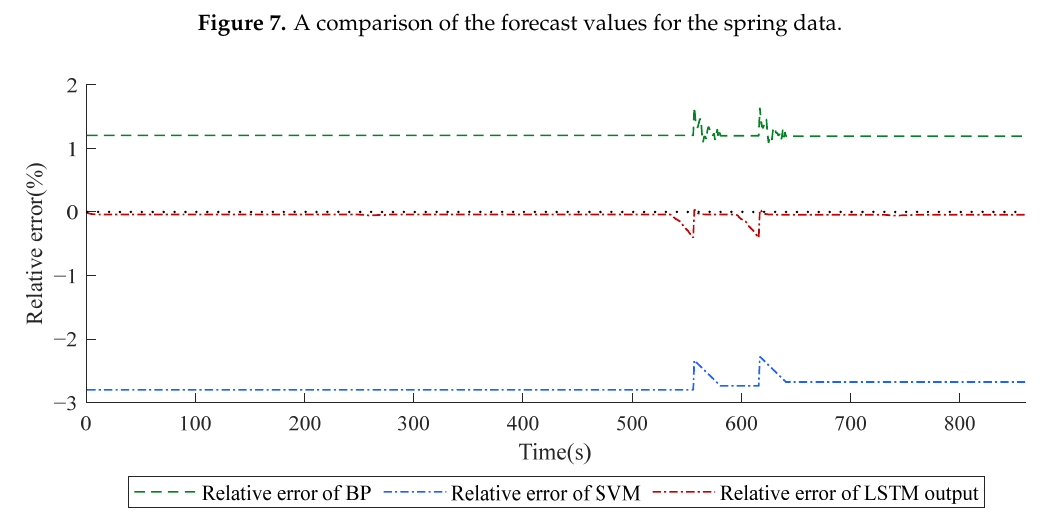
Figure 8. A comparison of the relative errors of the spring data forecast values.